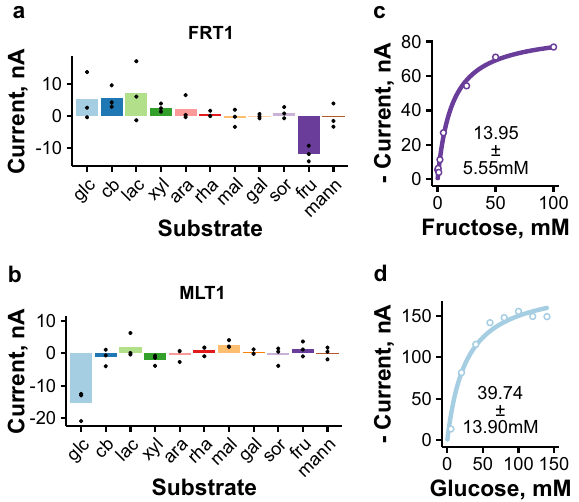
Figure 5. Electrophysiological characterization of hexose transporters FRT1 and MLT1. ( a , b ) Selectivity plots of FRT1 ( a ) and MLT1 ( b ) measured by recording currents in the presence of different sugars in 5 mM concentration (abbreviations as in Fig. 1). Results obtained with − 50 mV test voltage are shown. Points present results obtained from individual oocytes and bars their mean ( n = 3 ). ( c , d ) d-fructose transport kinetics of FRT1 ( c ) and d-glucose transport kinetics of MLT1 ( d ) at − 50 mV. Representative experiments are shown. Lines present Michaelis Menten kinetics prediction and the K m values present mean and standard deviation from individual oocytes ( n = 6 for Trire2_50618, n = 4 for Trire2_67469). The figure was created with ggplot2 package for R 79,85